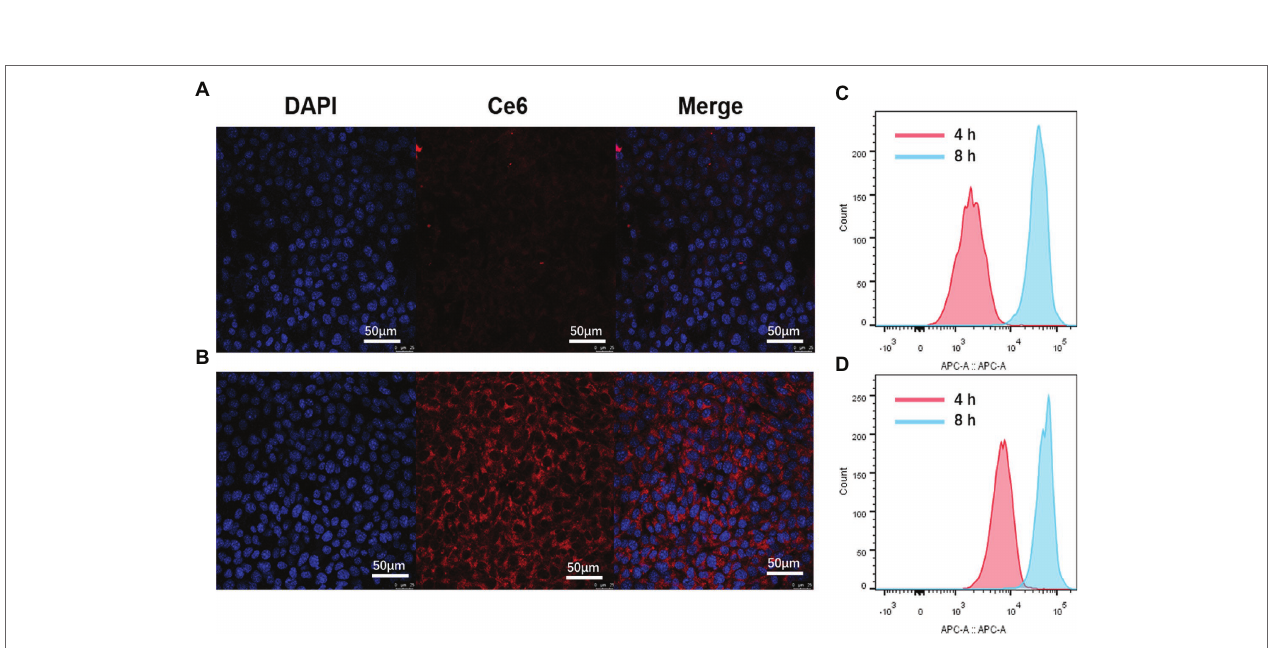
FIGURE 2 | (A) Singlet oxygen generation by the released Ce6 from the micelles treated with GSH. (B) Singlet oxygen generation by the released Ce6 from the micelles treated with